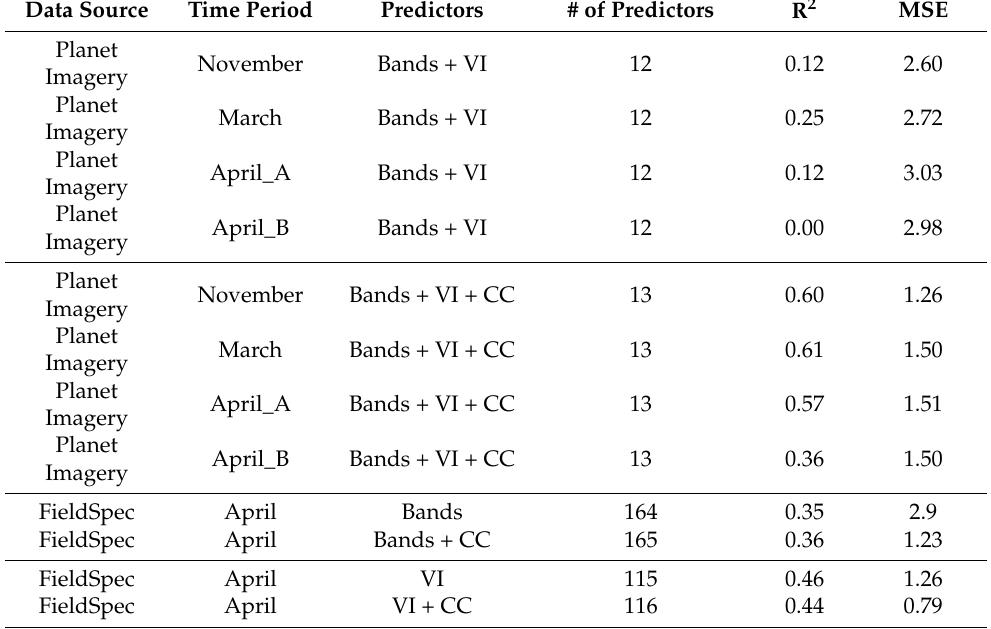
Table 5. Cover crop biomass prediction using random forest